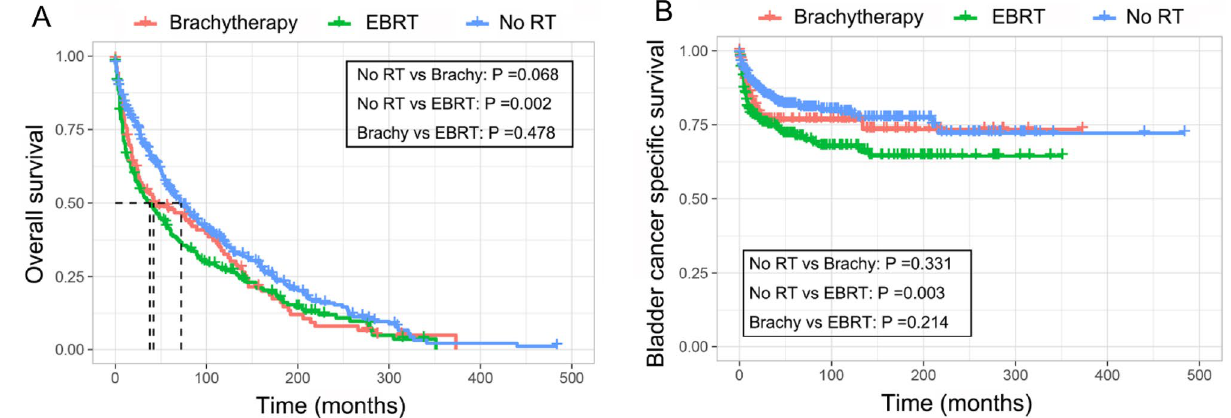
Figure 3. Kaplan–Meier curve of OS ( A ) and BCSS ( B ) in SBC patients received different RT modality after EC diagnosis. OS, overall survival; BCSS, bladder cancer-specific survival; EBRT, external-beam